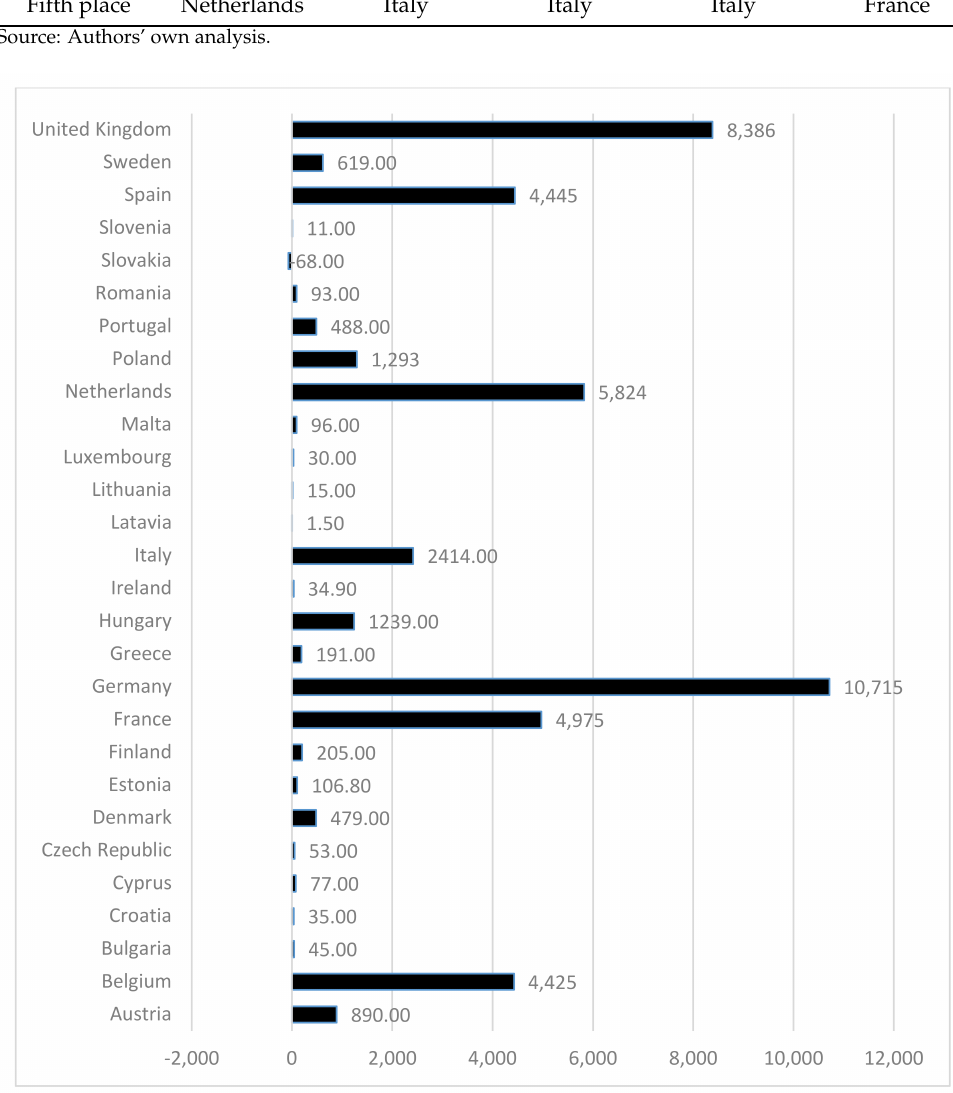
Figure 4. Photovoltaic installed capacity in years 2014–2019—European Union countries.